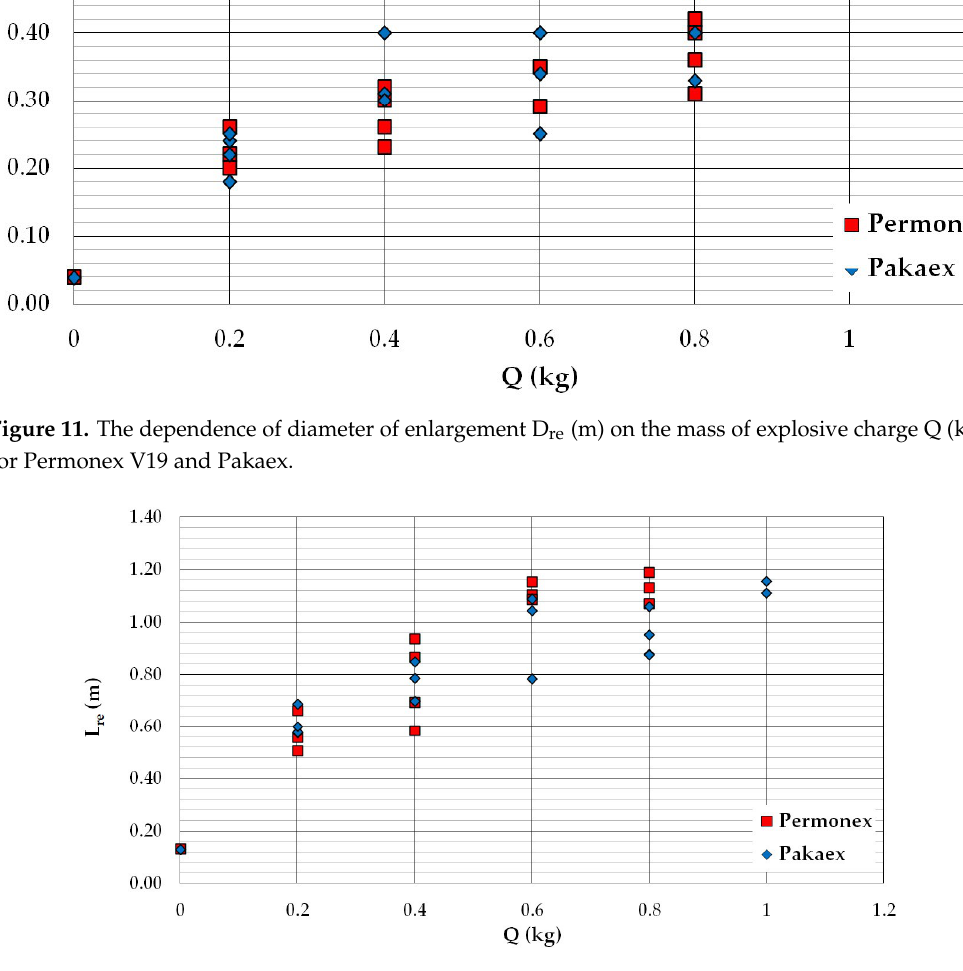
Figure 12. The dependence of the resulting deepening L re (m) on the mass of explosive charge Q (kg), for Permonex V19 and Pakaex.